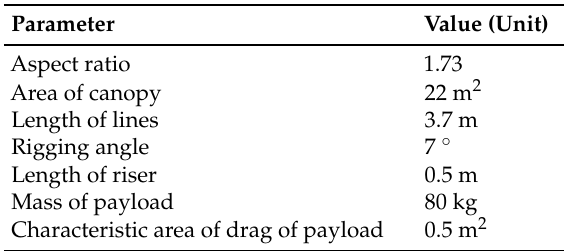
Table 1. The parameters of the parafoil and the